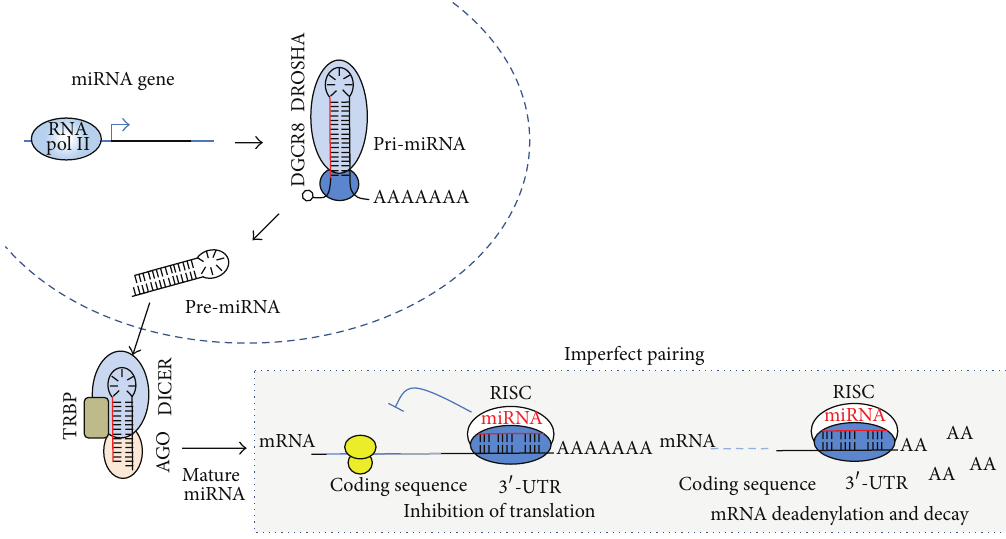
Figure 1: Biogenesis of miRNA. Transcription of miRNA by RNA polymerase II yields a long primary transcript (pri-miRNA) that contains a cap 5 󸀠 and poly-A tail. The complex DROSHA/DGCR8 cleaves pri-miRNA and gives rise to an miRNA precursor (pre-miRNA) that is exported to the cytoplasm and further processed by DICER endonuclease. An miRNA duplex associates with the RISC complex and retains the mature strand of miRNA. This complex directs imperfect binding to 3 󸀠 -UTR region of target mRNA, leading to a reduction in protein levels via translation blockage and mRNA deadenylation and